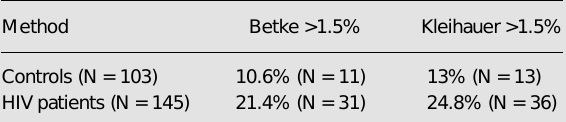
Table 1 - Hemoglobin F (%) and F cells (%) in controls and in HIV1/2 patients. Chi-square between controls and patients with the Betke method: 4.17, two-tailed, P = 0.041. Chi-square between controls and pa- tients with the Kleihauer method: 4.9, two-tailed, P = 0.026. Method Betke